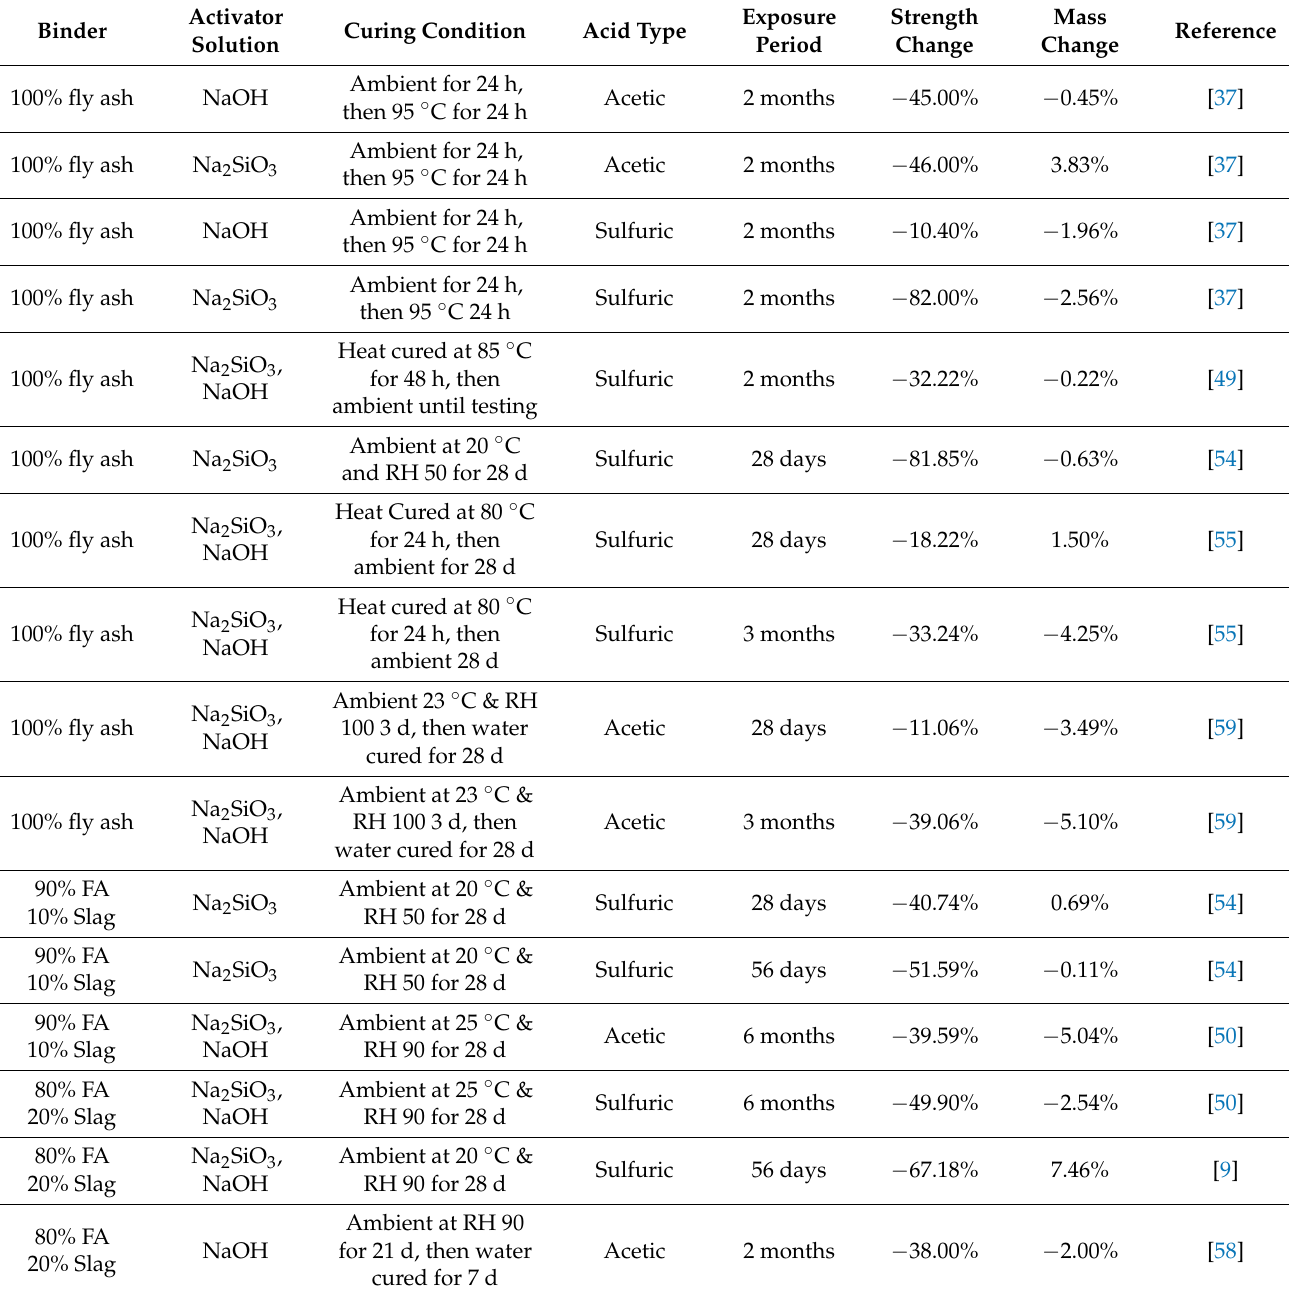
Table 2. Change in mass and strength due to the exposure of mortar to selected acidic